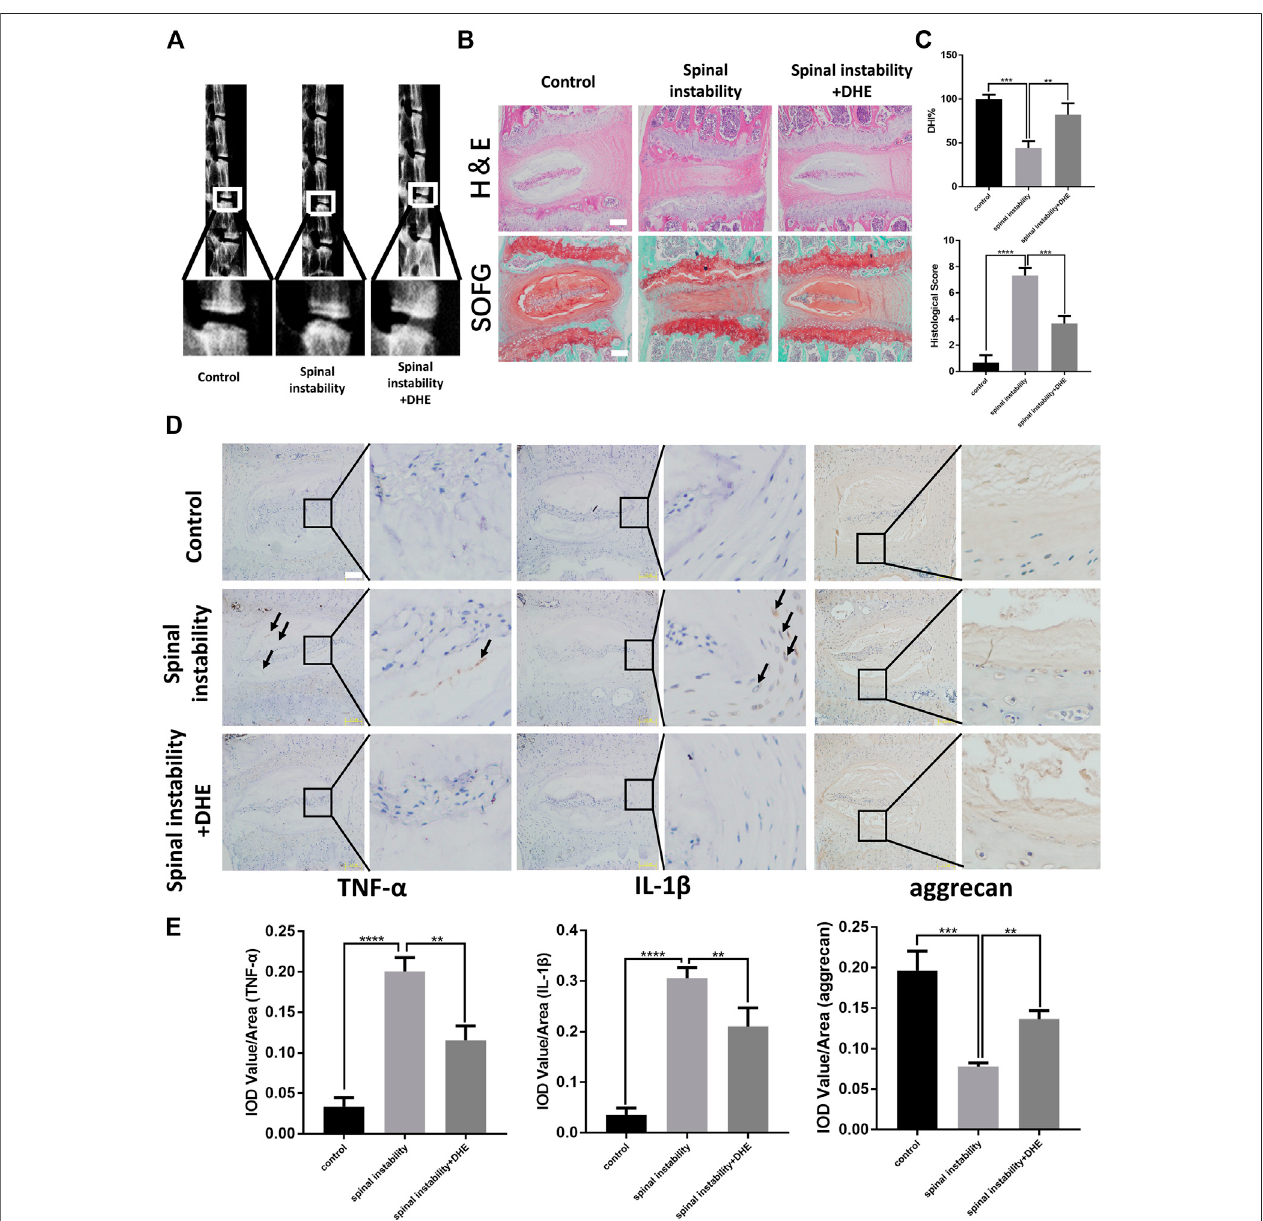
FIGURE 4 | Dehydrocostus lactone (DHE) ameliorated the progression of intervertebral disc degeneration (IDD) in a spinal instability – induced mouse model in vivo (A) ThelumbarspineX-rayofmiceat8 weeksaftersurgeryfromeachgroupandaspinalinstabilitymodelat12 weeksoldareshown (B) Hematoxylinandeosinstaining and safranin O-Fast green staining of intervertebral discs (IVDs) from each group at 8 weeks after surgery. Scale bar, 10 μ m (C) Histological scores of IVDs and quantitative analysis of disc height index (DHI, %) in mice at 8 weeks after surgery in the three groups. Scale bar, 5 μ m (D,E) Immunohistochemical staining of interleukin (IL)-1 β , TNF- α , and aggrecan expression (D) and their IOD Value/Area statistics (E) in IVDs at 8 weeks after surgery in the six groups. The arrows indicate IL- 1 β – and TNF- α – positive cells. Scale bar, 5 μ m. Data are presented as the mean ± SEM. n (cid:2) 6. ** p < 0.01, *** p < 0.001, and **** p < 0.001 relative to the control group.